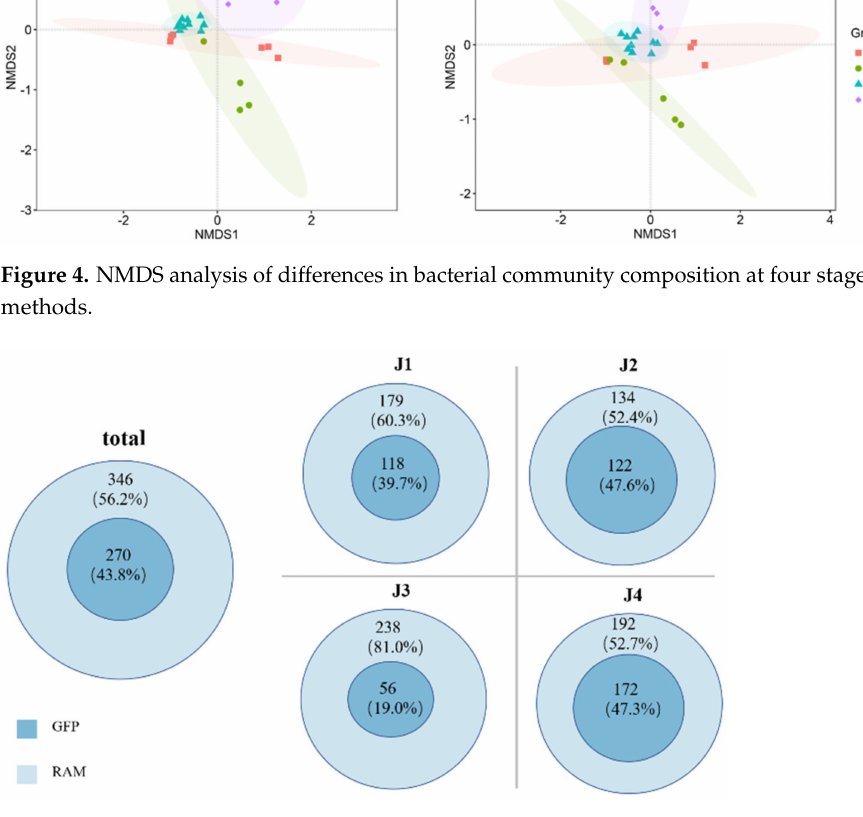
Figure 5. The difference in the amount of GFP and RAM in the four